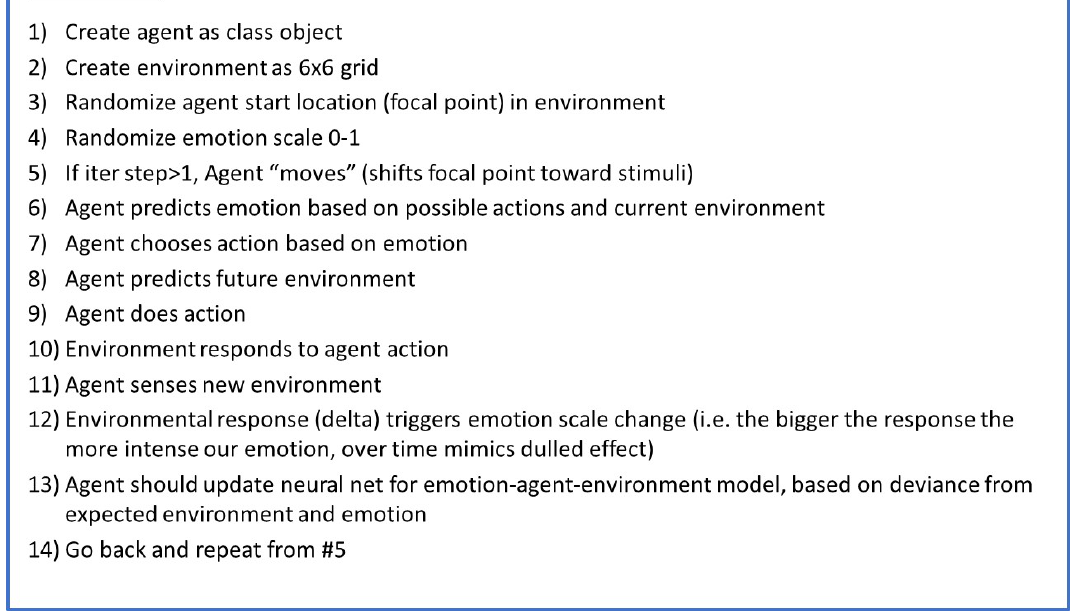
Figure 4. Simulation pseudocode.